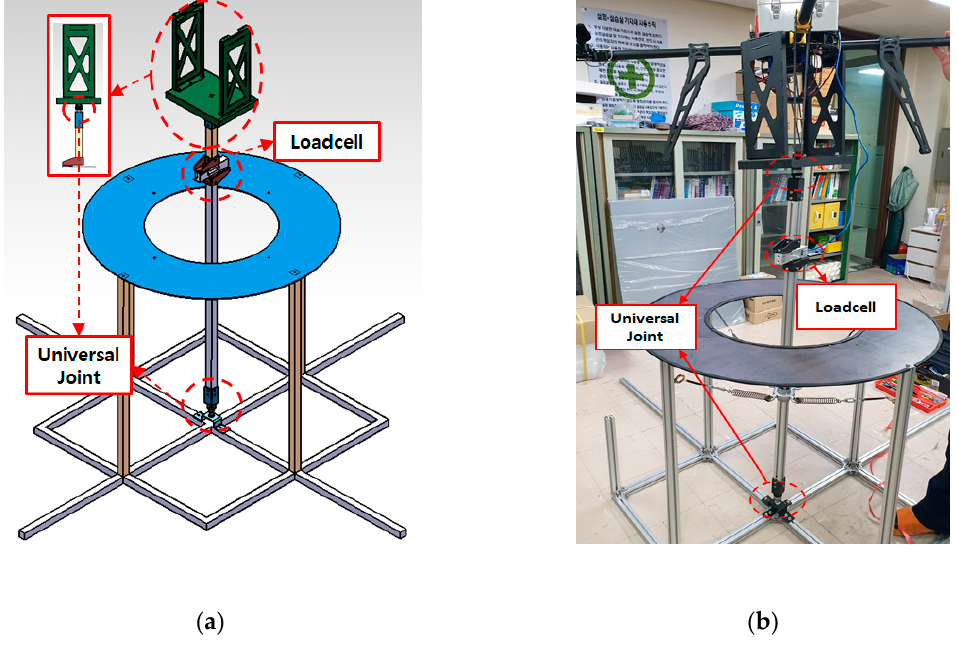
Figure 7. Configuring the testbed. ( a ) 3D modeling for the testbed; ( b ) assembling the testbed.